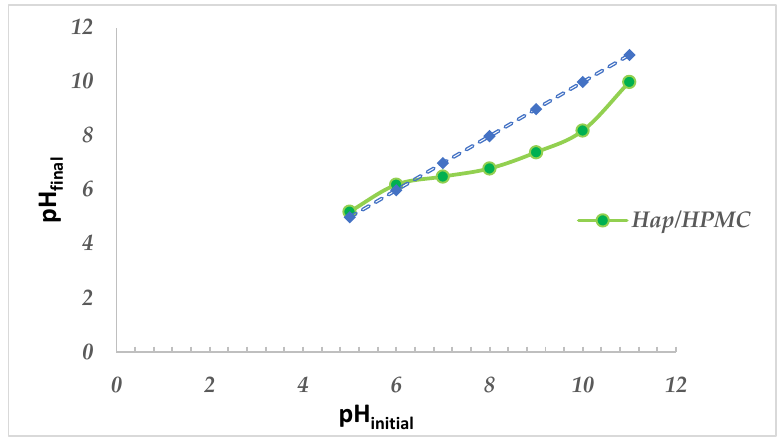
Figure 10. Determination of the pH pzc of the composite material HAp/HPMC 60/40.